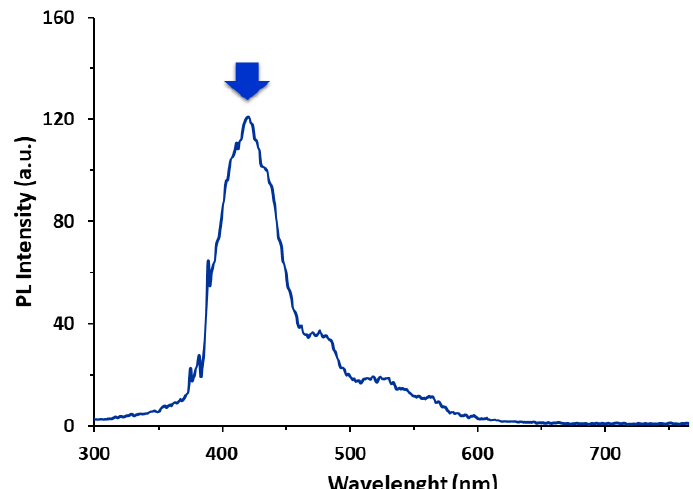
Fig. 6. Photoluminescence spectrum of synthesized NPs with =410 nm at room temperature Figure 6. Photoluminescence spectrum of synthesized NPs with